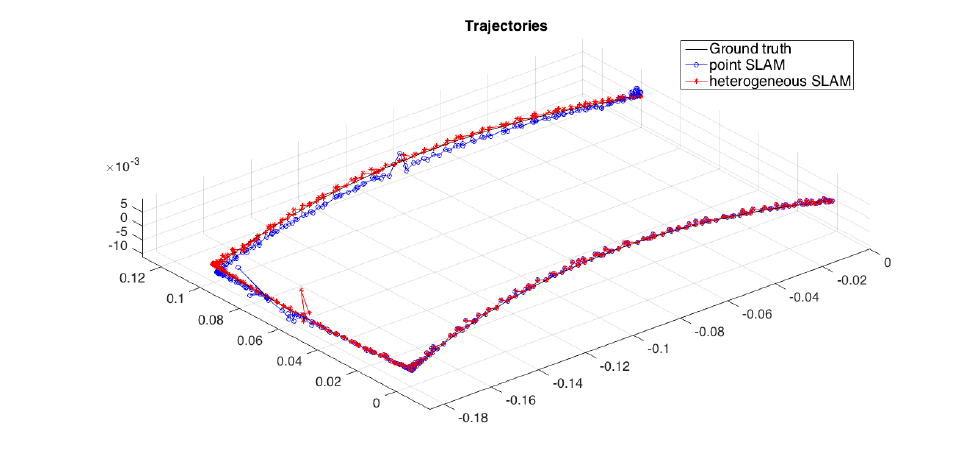
Figure 16. Ground truth, point SLAM estimated and heterogeneous SLAM estimated